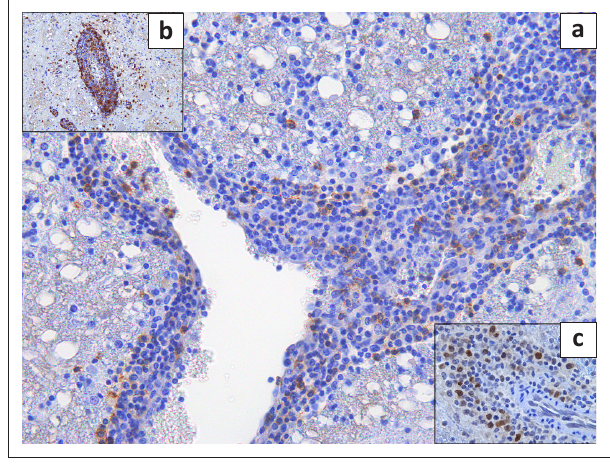
FIGURE 8: (a) Brain stem of lineage 2 West Nile virus infected Case 3 with severe perivascular cuffing with immunohistochemistry cluster of differentiation 20+ (brown) B-lymphocytes or plasma cells scattered in the cuff and the parenchyma. Cluster of differentiation 20 immunoperoxidase using LSAB+ DAB as chromogen and haematoxylin counterstain x 400. (b) Case 3 brainstem with perivascular and parenchymal cluster of differentiation 3+ (brown) T-lymphocytes. Cluster of differentiation 3 immunoperoxidase using LASB+ DAB as chromogen and haematoxylin counterstain x 200. (c) Case 3 brainstem perivascular multiple myeloma oncogene 1+ labelled (dark nuclei) plasma cells. Multiple myeloma oncogene 1 immunoperoxidase using polymer DAB as chromogen and haematoxylin counterstain x 1000.